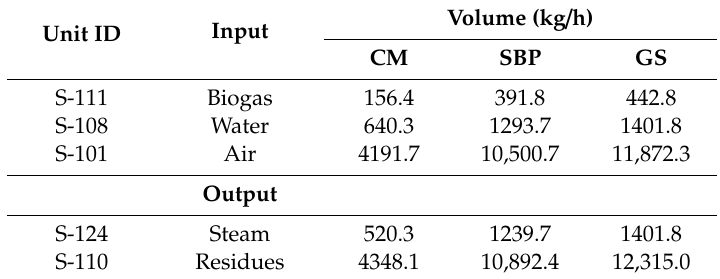
Table 5. The input and output of the CHP unit for the feedstocks CM, SBP, and GS.